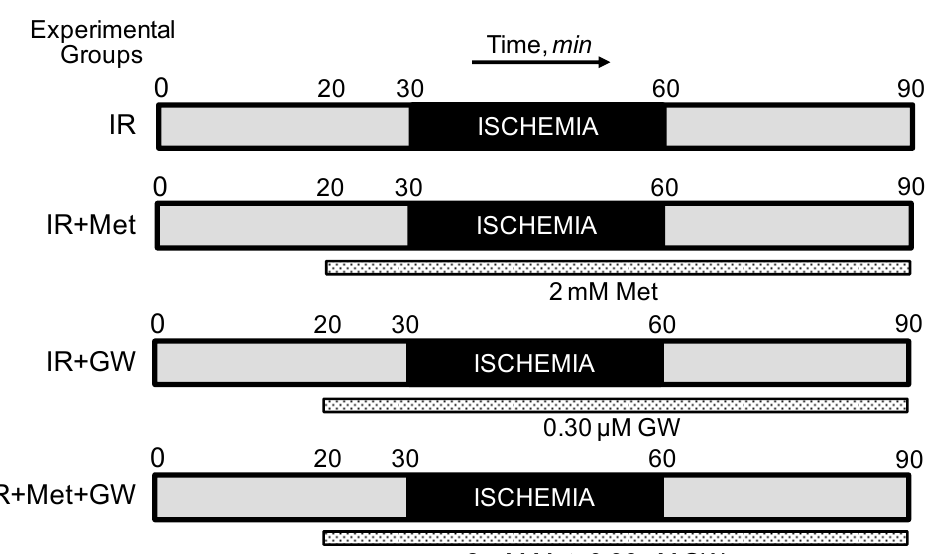
Figure 1. Perfusion protocols for Langendorff heart preparation. Experimental